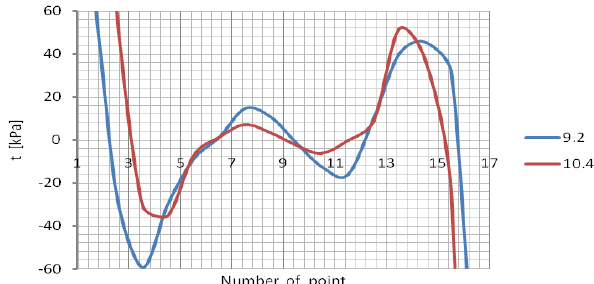
Figure 12: Intensity of the tangential interaction in the contact